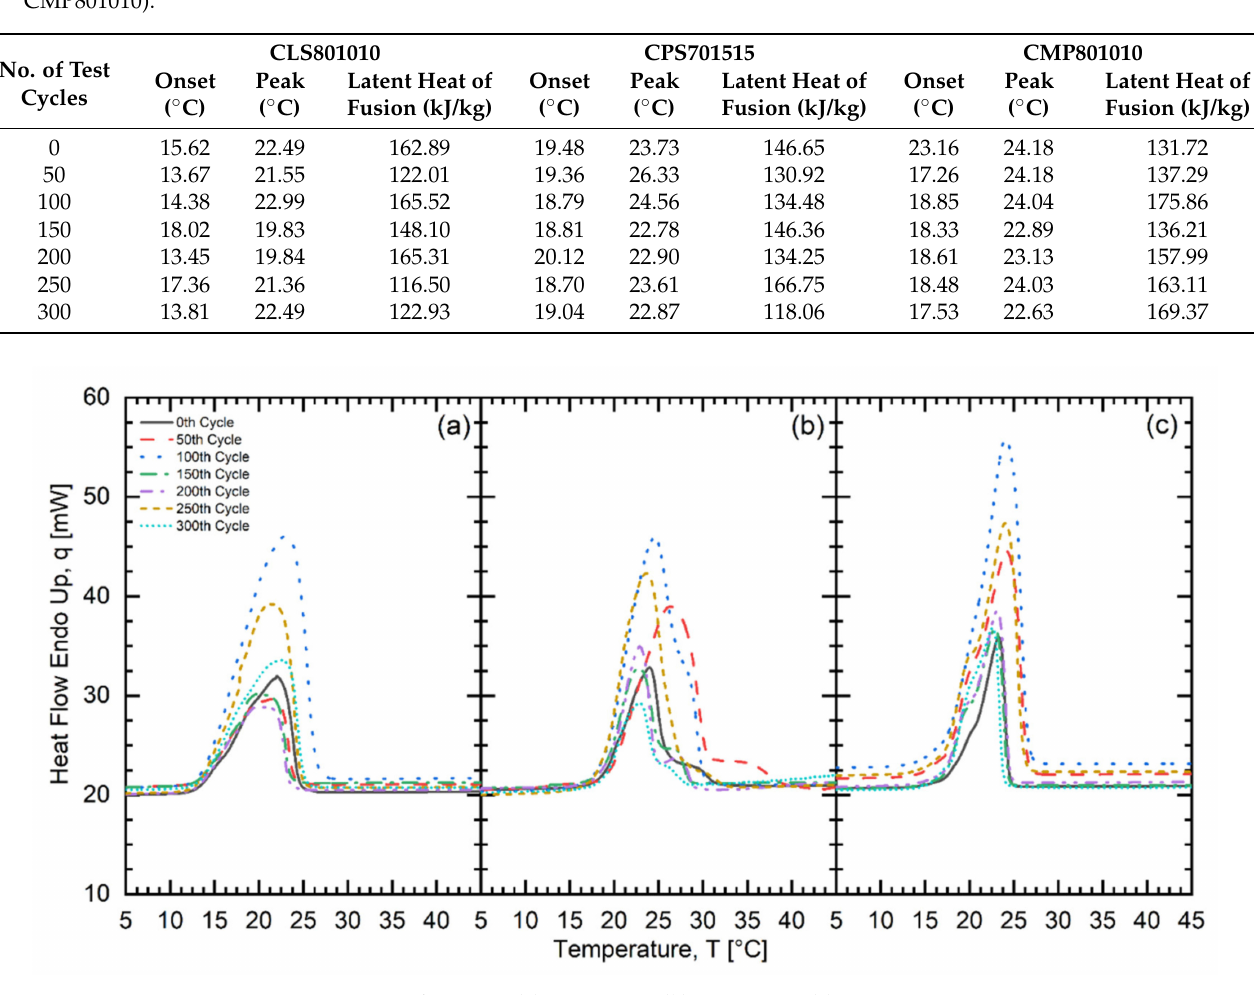
Figure 8. Cycle testing ( a ) CLS801010 ( b ) CPS701515 ( c )